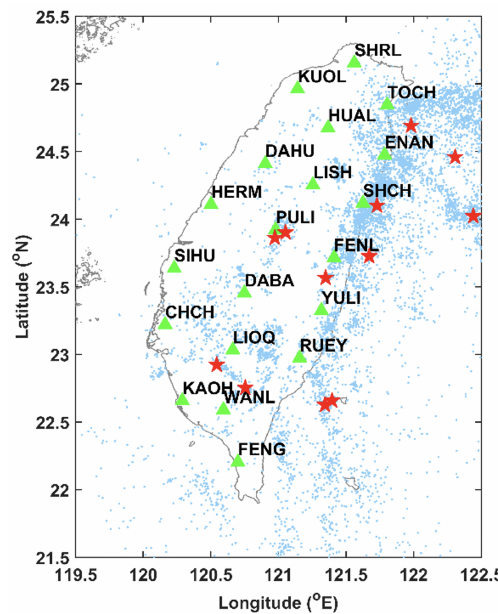
Figure 1. Map of the spatial distributions of seismicity and geoelec- tric stations (green triangles) in Taiwan. In this figure, past EQs with M L ≥ 3 are shown as light blue dots and past EQs with M L ≥ 6 are shown as red